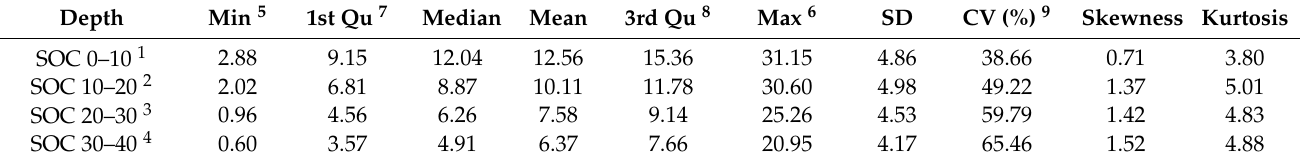
Table 2. Descriptive statistics for SOC concentration of 386 sampling points (g kg − 1 ).